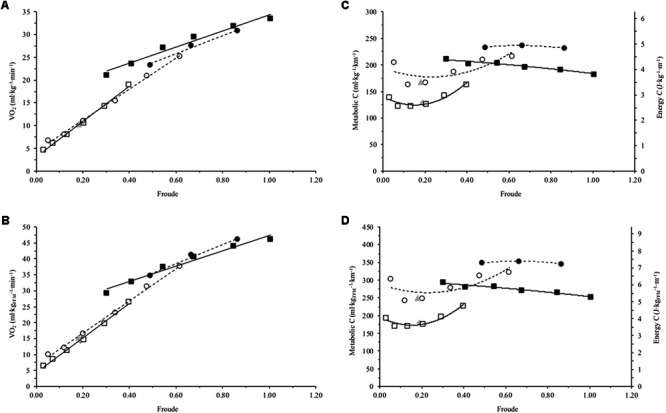
Mean net oxygen consumption (V͘O2) and metabolic cost (C) for Achondroplasia (◦) and control (□) when walking (open) and running (closed) at mean Froude’s numbers (Fr); SSW are presented for Achondroplasia () and control () respectively. V͘O2 and C are presented relative to total body bass (A and C, respectively) and relative to fat free mass (B and D, respectively); C is also presented as the energy cost by considering 1 ml of O2 = 20.9 J. V͘O2 and Fr relationships are fitted with a linear trend line, while C and Fr relationships are fitted with a 2nd order polynomial with the broken and continuous line being the trends for the Achondroplasic and control group, respectively. SD is omitted for clarity.